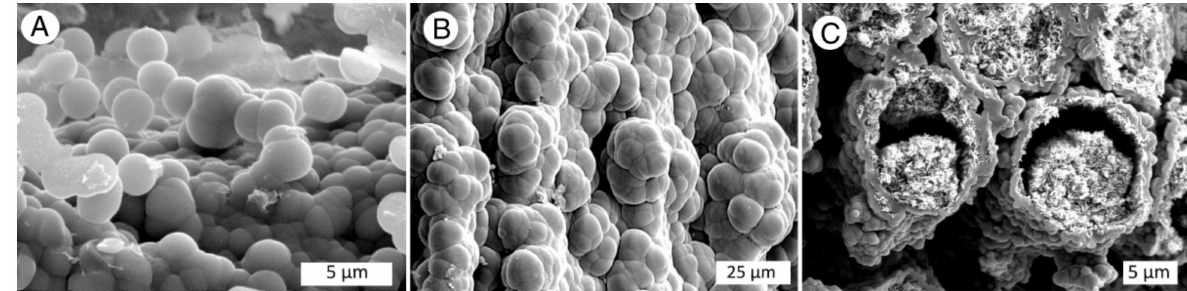
Figure 7. Morphologies of opal-A in Miocene wood from Nevada, USA [25]. ( A ) Lepispheres. Hazen, Churchll County. ( B ) Botryoidal texture of opal coating wood fibers. Rainbow Ridge Mine, Virgin Valley, Humboldt County ( C ). Porous aggregates filling cell lumen, with botryoidal cell walls replaced by botryoidal opal. The lumen are only partially filled, leaving crescent-shaped open spaces. Specimen from Virgin Valley, Humboldt County. Specimen provided by John Church.